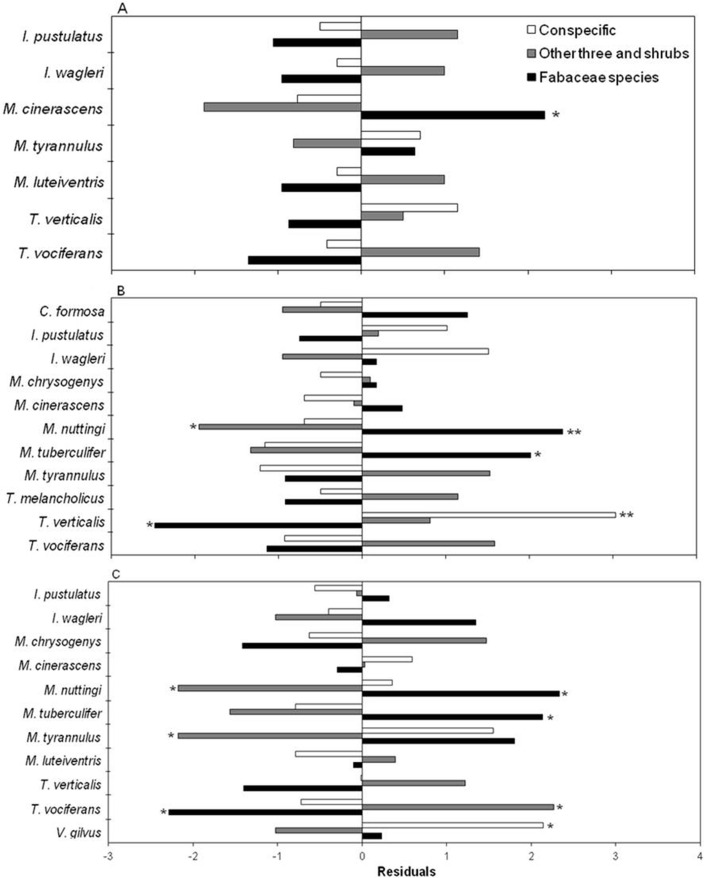
Residuals of a contingency table comparing perching sites for birds after consumption of B. longipes fruit in three stages of succession: (A) early, (B) intermediate and (C) mature.Bars represent frequencies, and significant residuals indicate preference (positive residual) or avoidance (negative residual) by each bird species. * p < 0.05, ** p < 0.01.